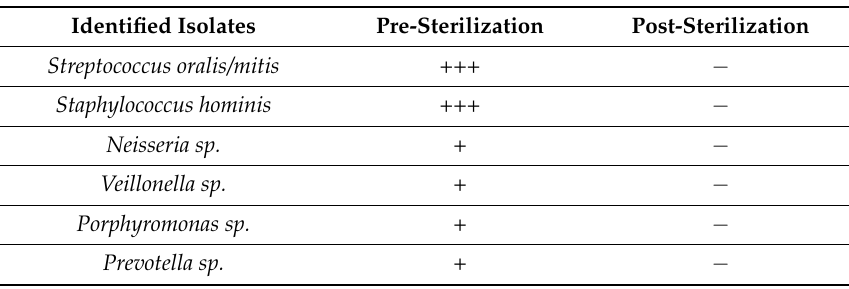
Table 1. Selected bacteria isolated from discs. Identified Isolates